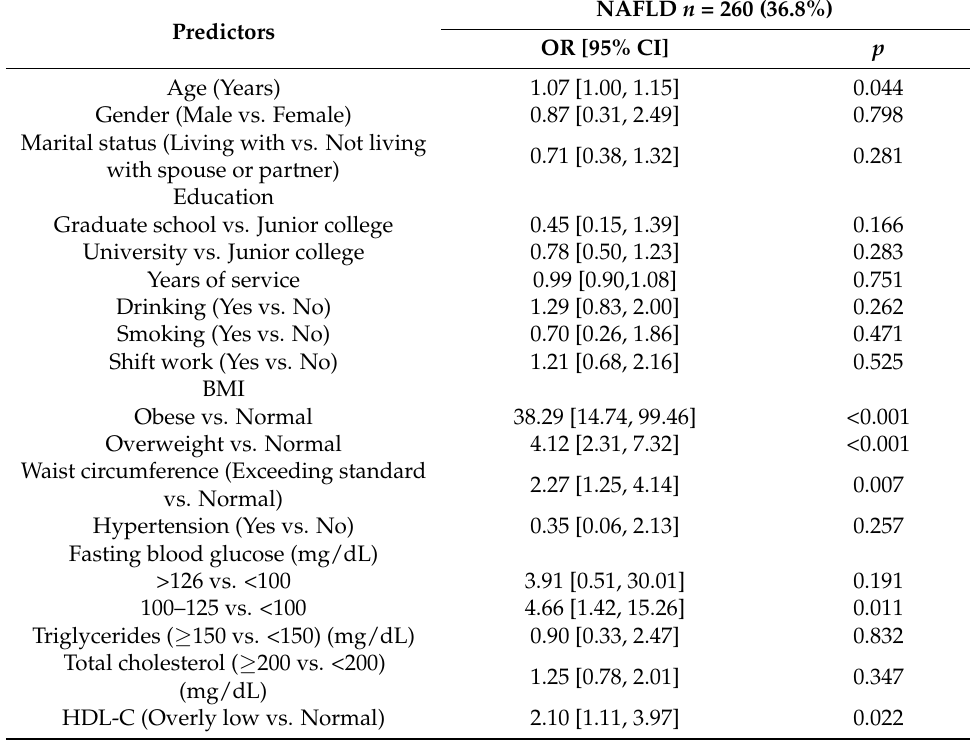
Table 2. Multinomial logistic regression analysis of factors influencing NAFLD in